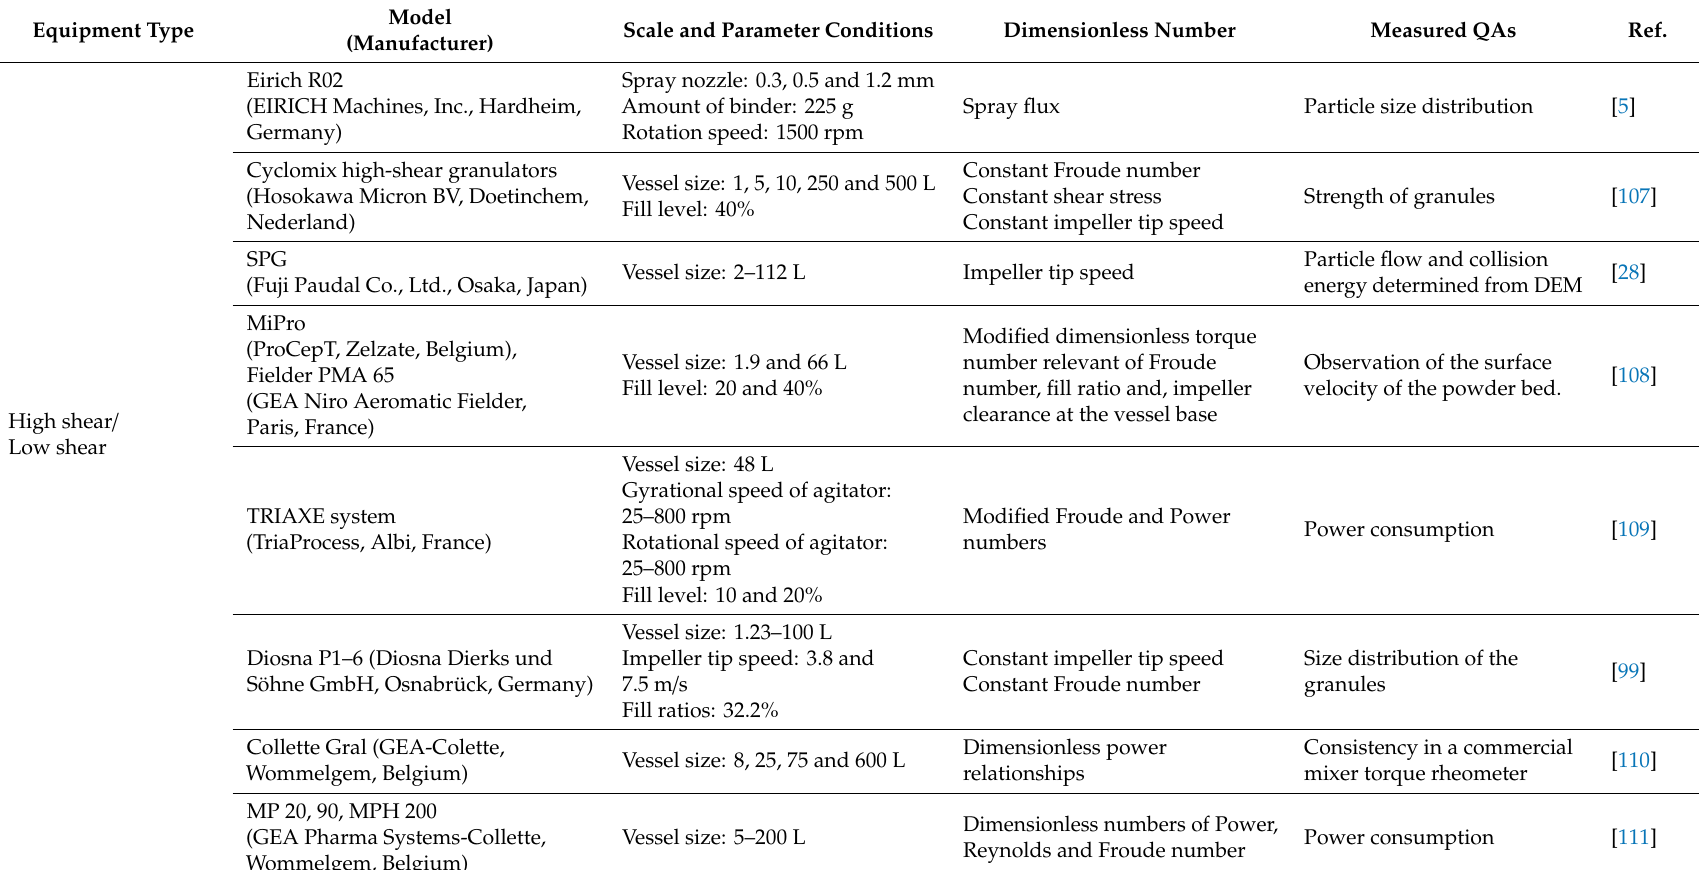
Table 3. Summary of engineering-based modeling method applied in wet granulation